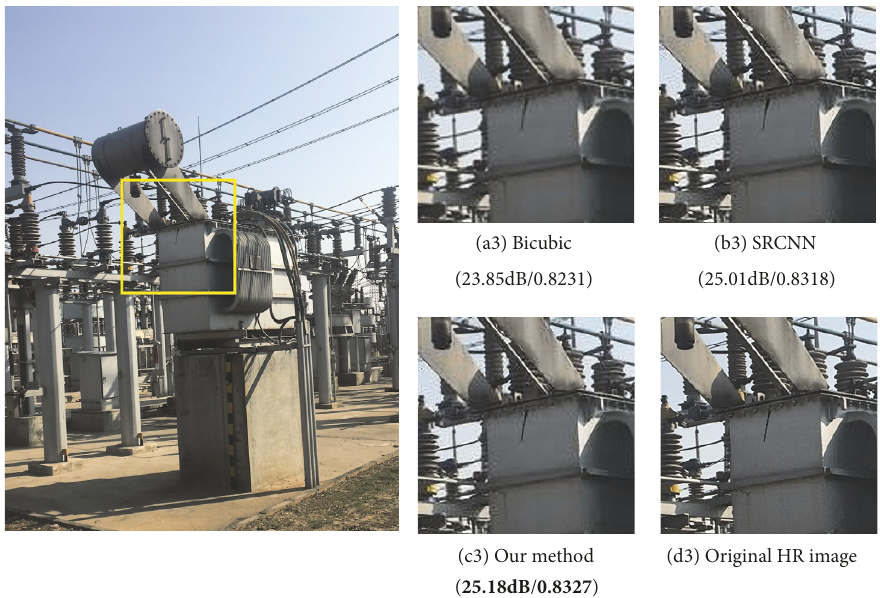
Figure 7: Simulated cracks in the 35 kv